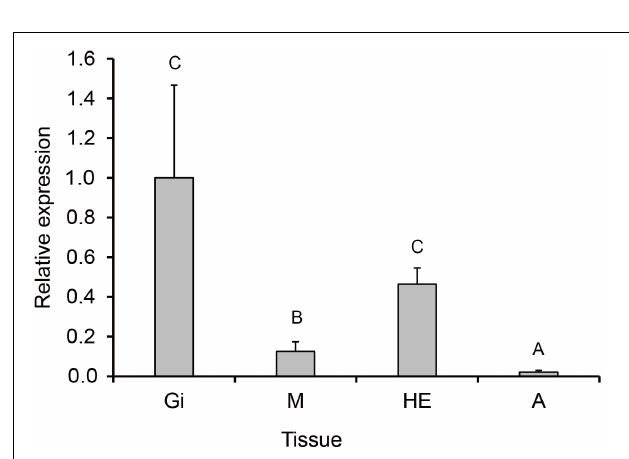
FIGURE 5 | Tissue distribution of PmHSP70 mRNA expression. Different capital letters indicate significant differences ( P < 0.05). The four tissues include gills (Gi), hepatopancreas (He), mantle (M), and adductor muscle